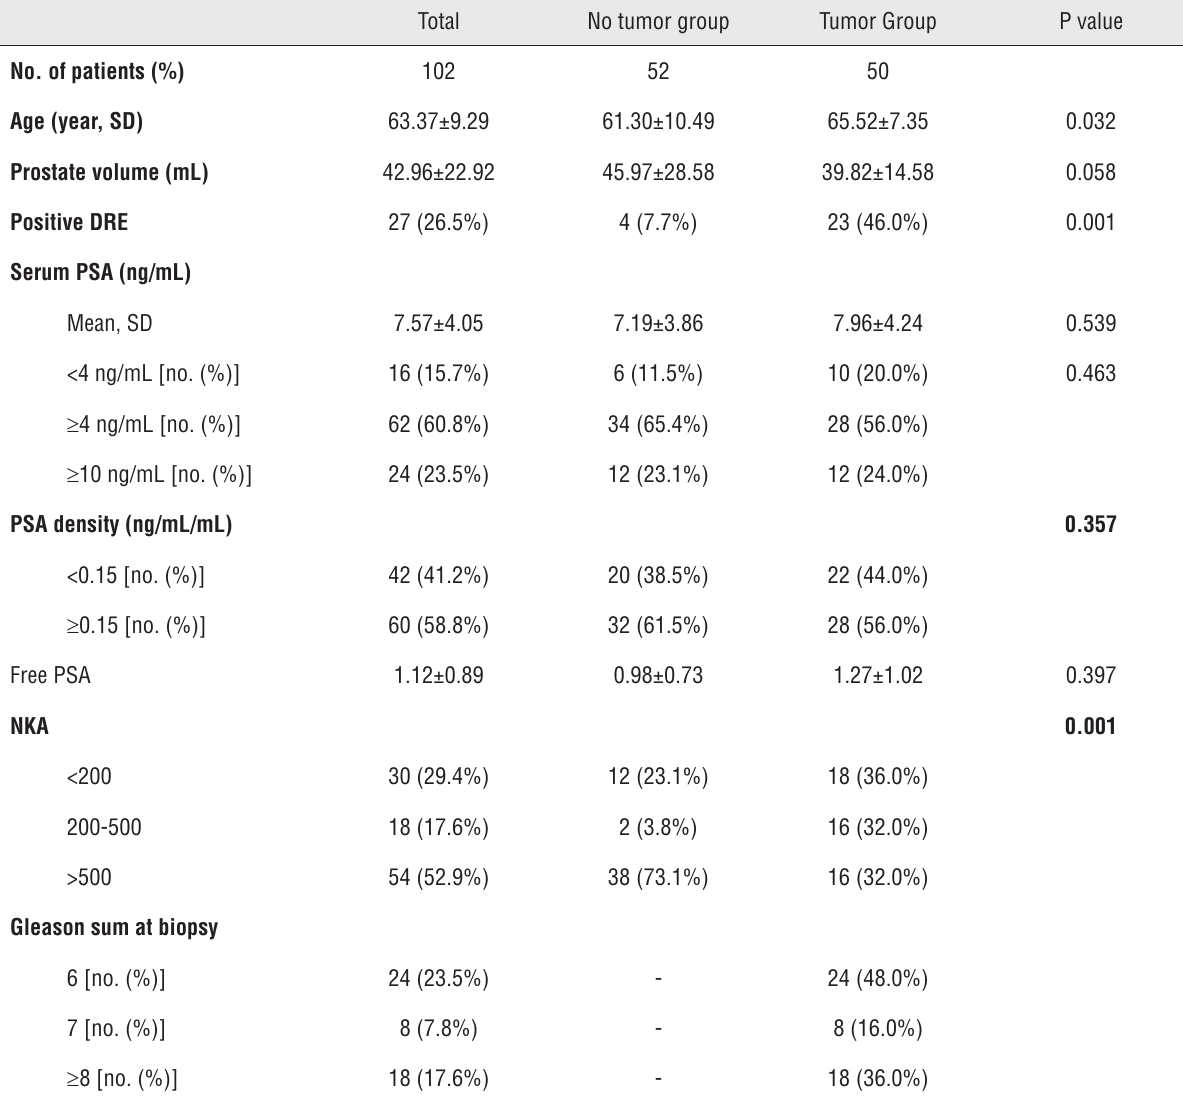
Table 1 - Baseline characteristics of the studied population (n = 102). Total No tumor group Tumor